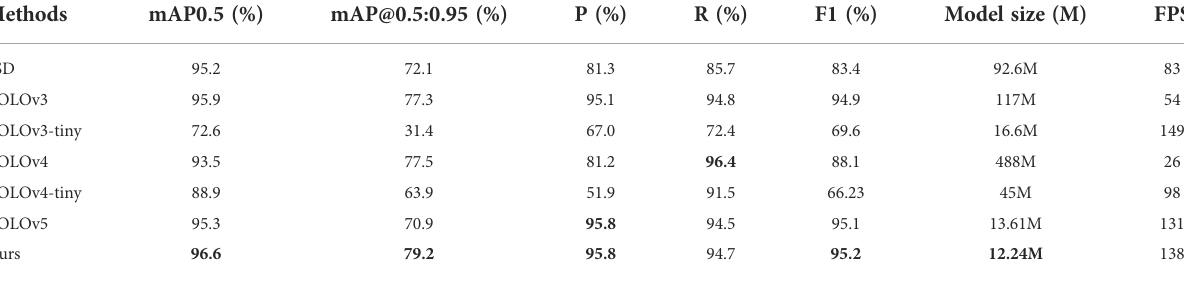
TABLE 1 Performance comparison of SSD, YOLOv3, YOLOv3-tiny, YOLOv4, YOLOv4-tiny, YOLOv5 and the proposed algorithm in the ship dataset. Methods mAP0.5